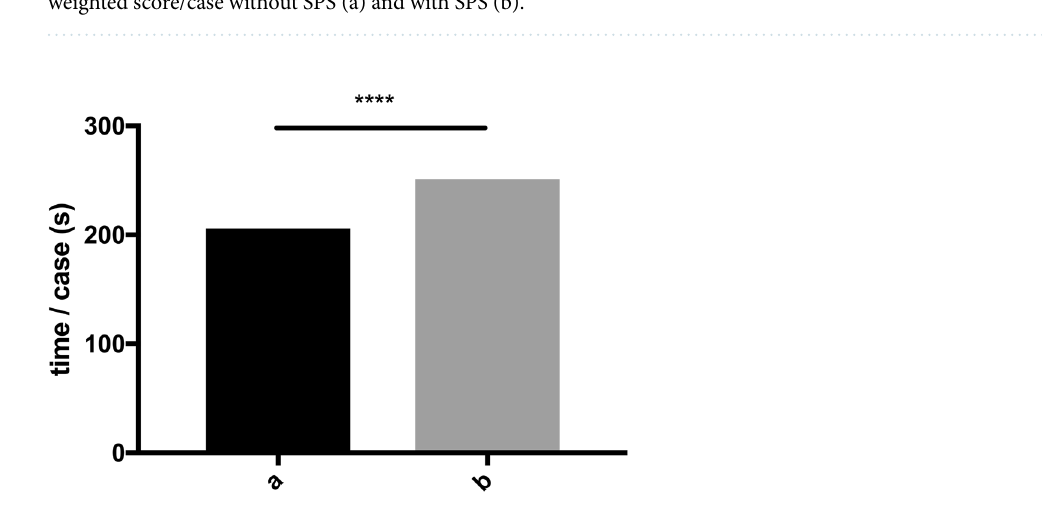
Figure 5. Mean time/case in seconds without SPS (a) and with SPS